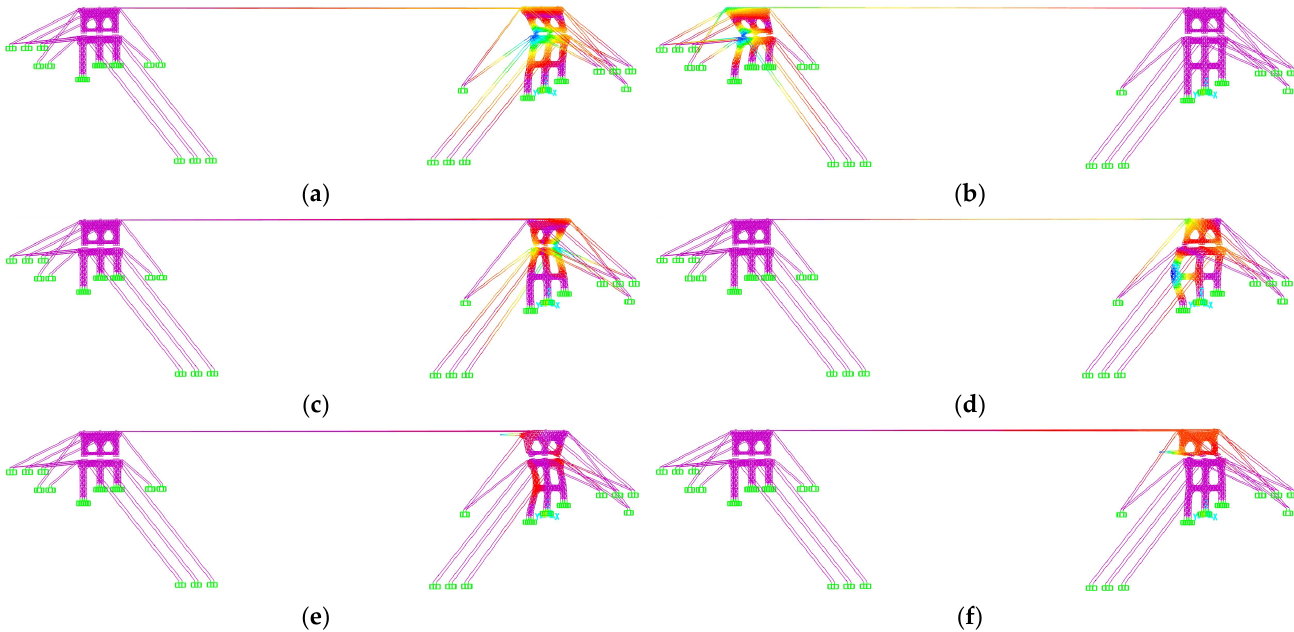
Figure 12. First six orders of buckling mode characteristics of towers: ( a ) buckling mode 1; ( b ) buckling mode 2; ( c ) buckling mode 3; ( d ) buckling mode 4; ( e ) buckling mode 5; and ( f ) buckling mode 6.